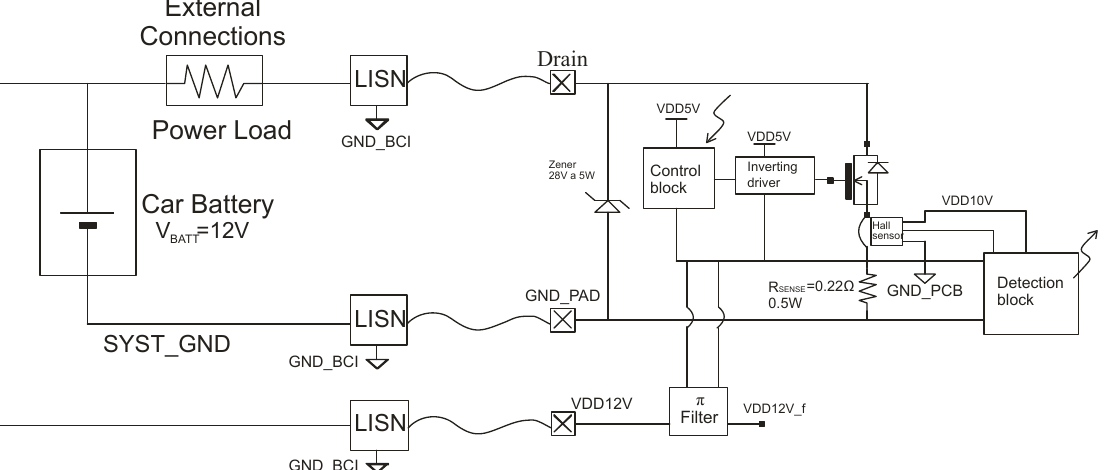
Figure 5. Overall schematic view of the current detection